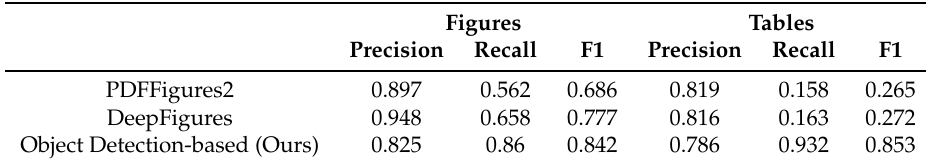
Figure 7. Recall over different values for the correctness threshold. We can see that the segmentation-based system is similar to PDFFigures2 in that almost all of its detections are localized very precisely. Both, the object detection-based system and DeepFigures tend to detect many document elements, but are not as precisely. ( a ) Figures; ( b ) Tables. Table 3. Results of running the evaluation on Mixed-Large-Test when presupposing the caption-oriented definition